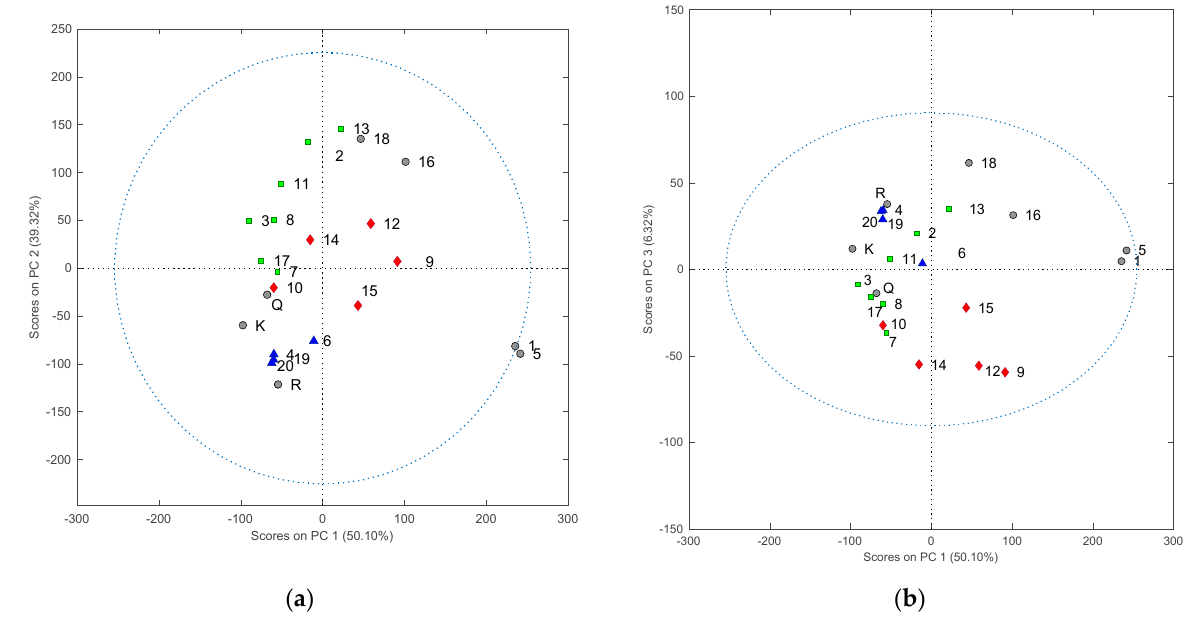
Figure 6. MPCA scores plot based on 2T2D correlation maps calculated for two spectra of 80% methanol extracts food supplements vs. ginkgo XRM as sample and reference spectrum, respectively. Figure ( a ) presents score plot PC1 vs. PC2 and ( b ) PC1 vs. PC3. RMSEC: 0.081; RMSECV: 0.101. The blue triangles indicate supplements with rutin as the main component, red diamonds indicate supplements with quercetin as the main component, and green squares represent supplements with quercetin and kaempferol as the main components. The probability of confidence ellipse was 90%. For comparison, results of PCA based on conventional 1D UV-Vis spectra were shown in Figure S7.